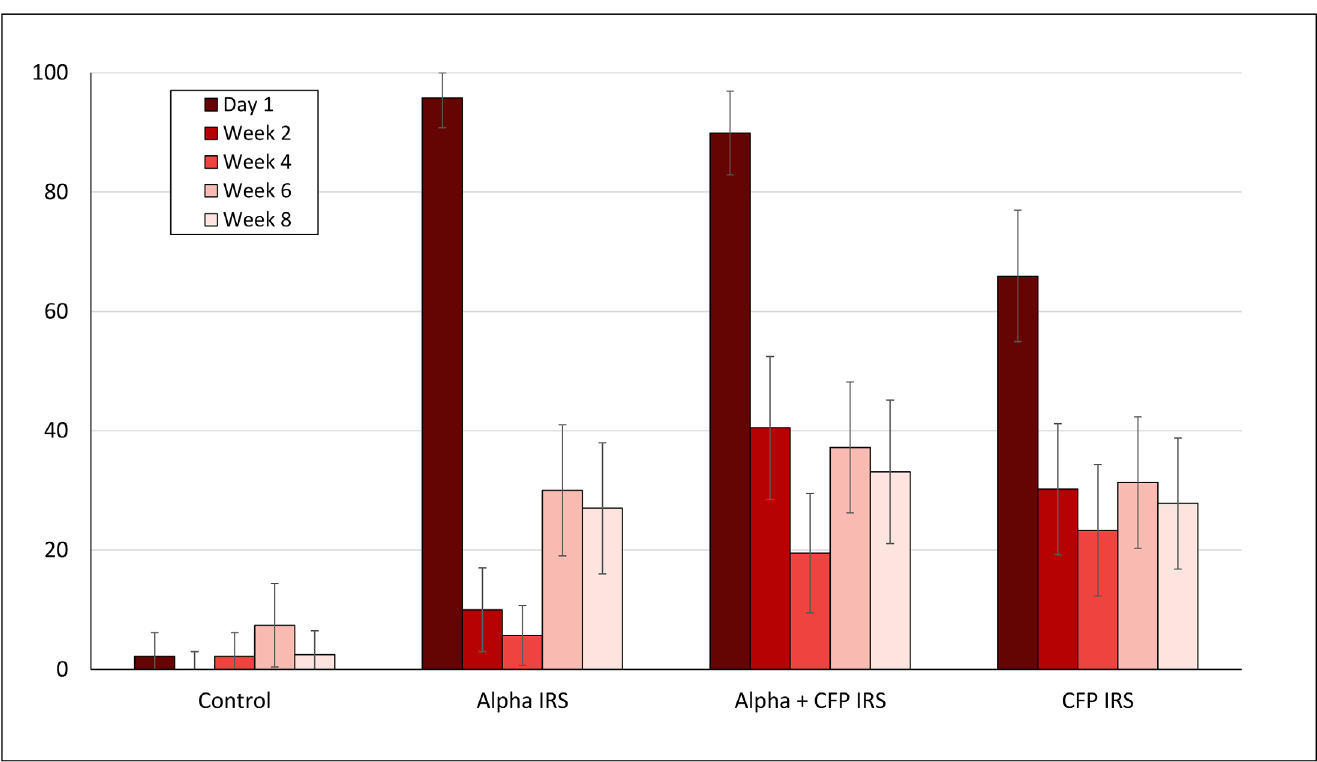
Fig 3. Mortality (%) of pyrethroid resistant An gambiae Cove in fortnightly in situ cone bioassays in IRS treated experimental huts in Cove. Mosquitoes were collected as larvae from breeding sites close to the experimental huts. Error bars represent 95% CI. alpha = alpha-cypermethrin, CFP =